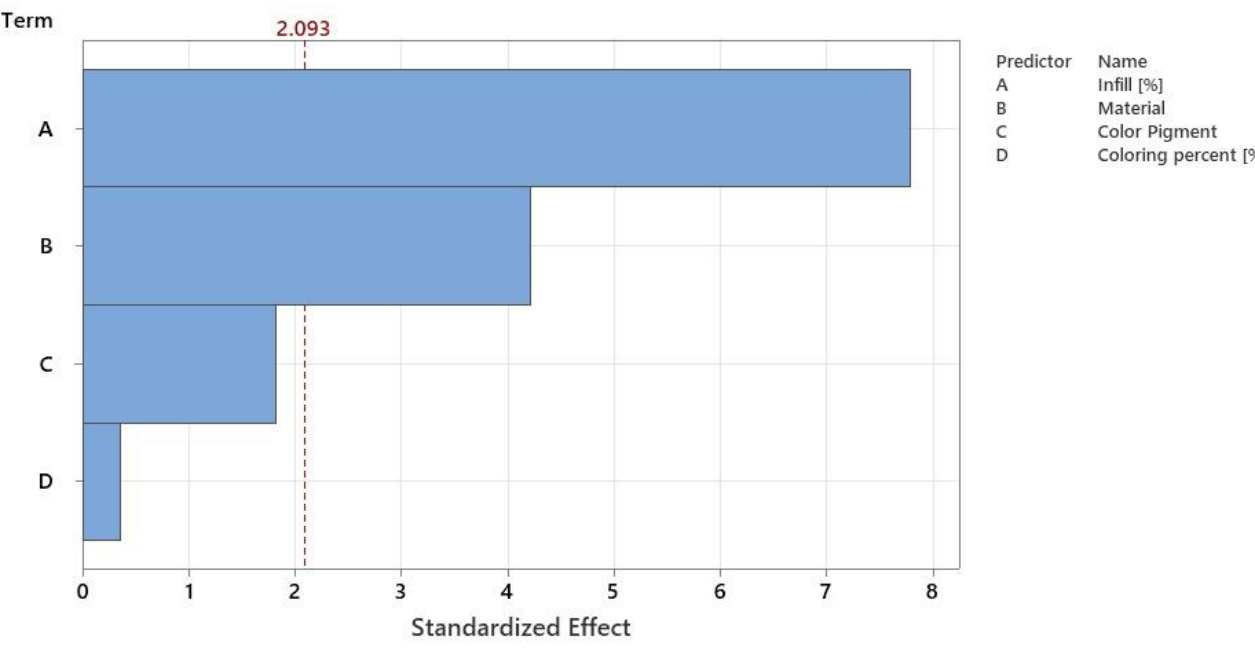
Figure 14. Pareto graph for the significance level of the studied factors for tensile tests.